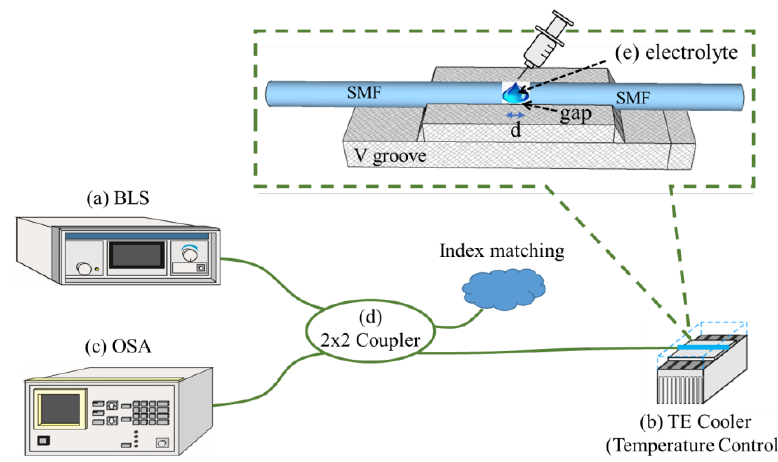
Figure 4. Schematic of the experimental setup: ( a ) broadband light source (BLS); ( b ) proposed AGFFPI sensing device and the thermoelectric (TE) cooler (TEC); ( c ) optical spectrum analyzer (OSA); ( d ) 2 × 2 optical coupler; ( e ) positive electrolyte under test.